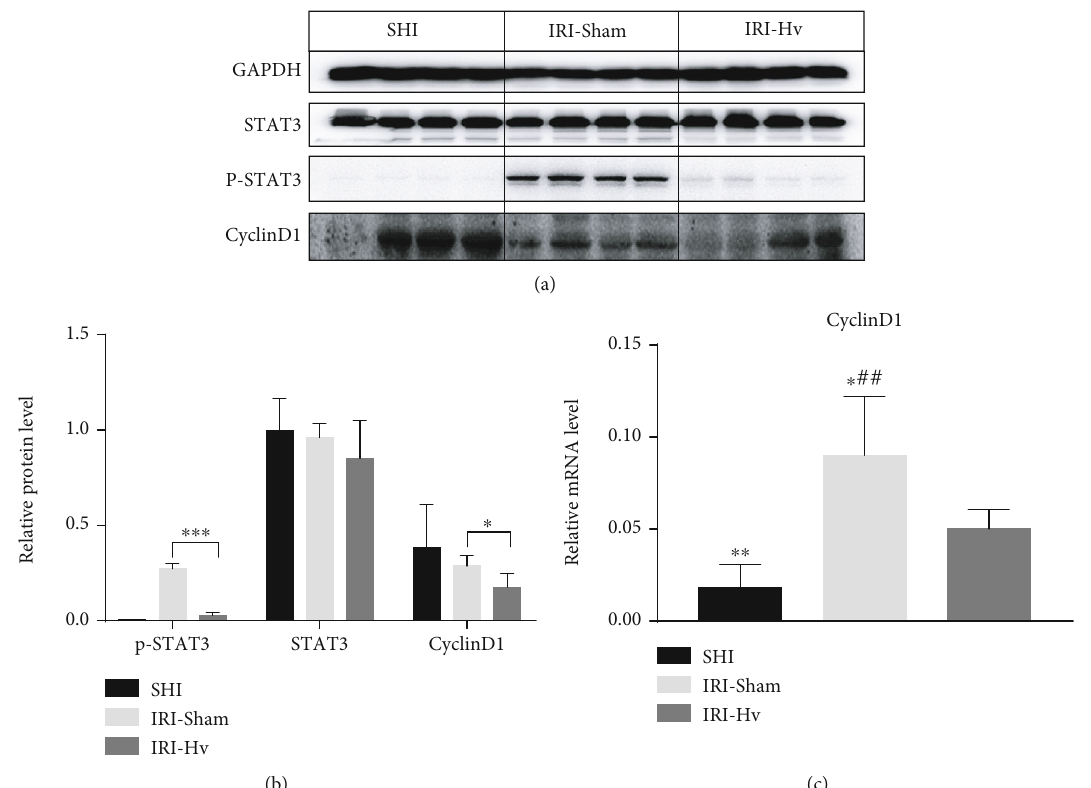
Figure 4: E ff ects of hepatic vagotomy on STAT3, p-STAT3, and cyclinD1 activation after reperfusion. (a, b) Western blotting was used to detect the expressions of STAT3, p-STAT3, and cyclinD1 proteins in livers of di ff erent groups (6 h). (c) Expression of cyclinD1 mRNA in di ff erent groups at 6h after reperfusion ( n = 4 ‐ 5 ; compared with the IRI-Hv group: ∗ p < 0 : 05 and ∗∗ p < 0 : 01 ; compared with the SHI group: ## p < 0 : 01